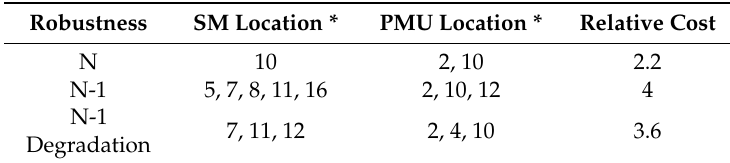
Table 2. Location of Smart Meter and